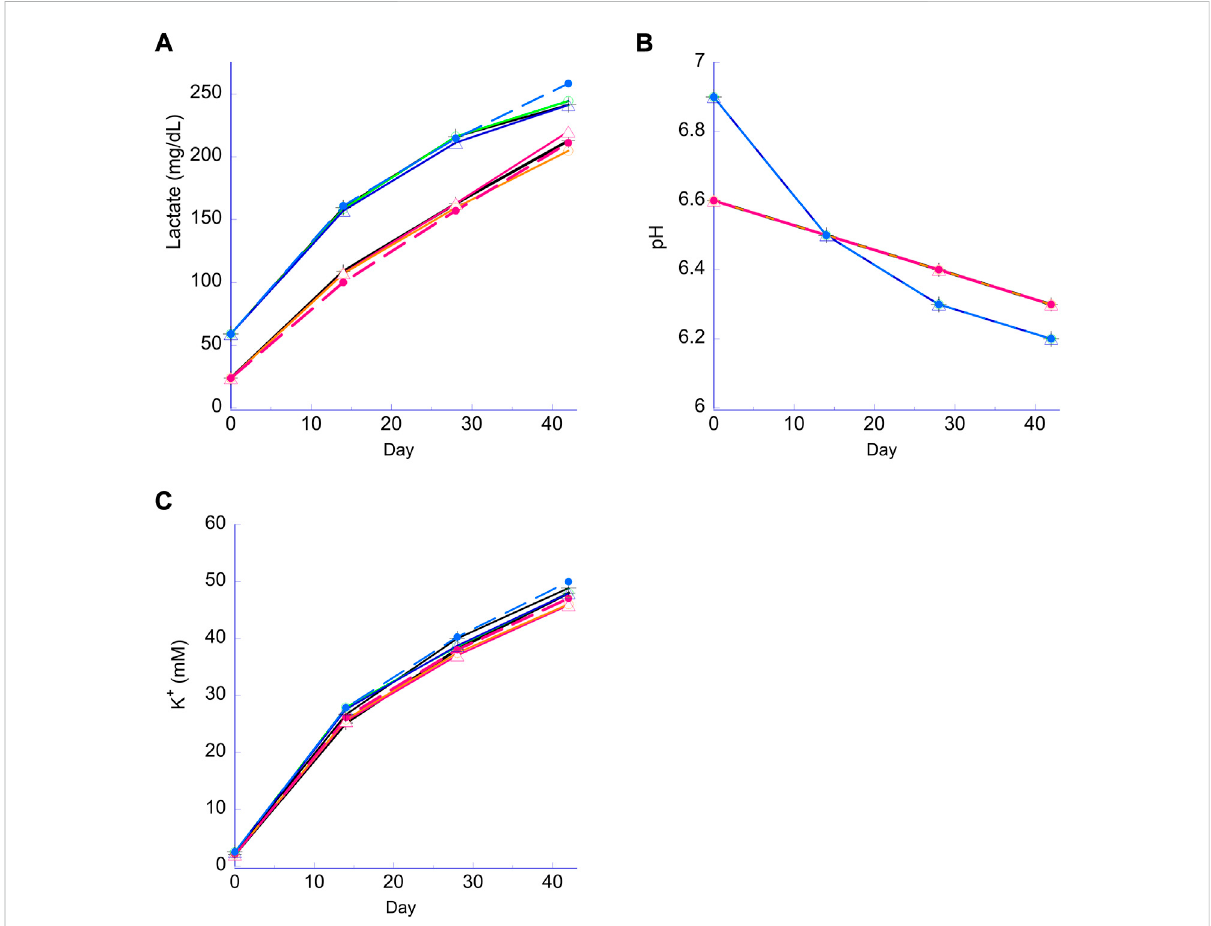
FIGURE 3 Lactate, pH and extracellular K+. Panel (A) lactate for both the N RBC (lower lines) and H RBC (higher lines). Panel (B) pH for both the N RBC (family of lines stating lower at Day 0); H RBC (family of lines starting higher then cross over at week 2); Panel (C) K + (differences are negligible and within precision of the analyzer.) Broken lines, PVC bag; open triangle, 2 PVC strips; open circle, 1 PVC strip; cross, no PVC